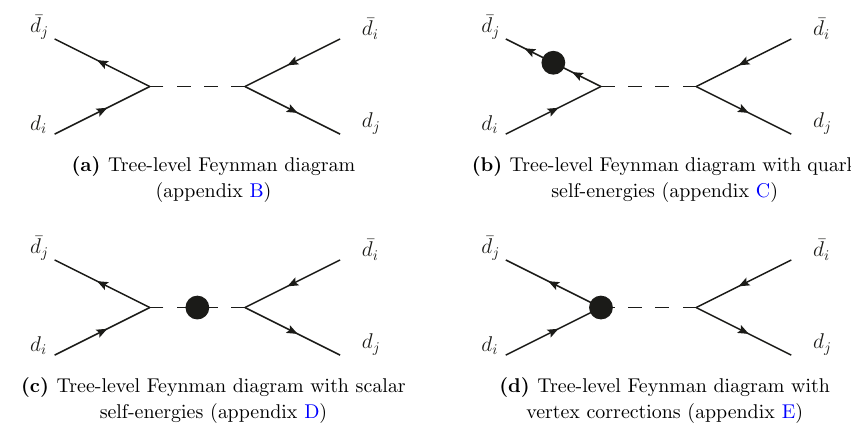
Figure 1. The tree level diagram and its one-loop